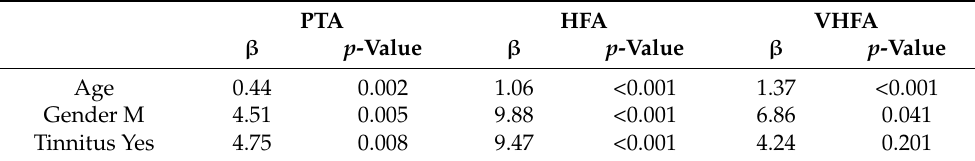
Table 7. Results from the multiple regression